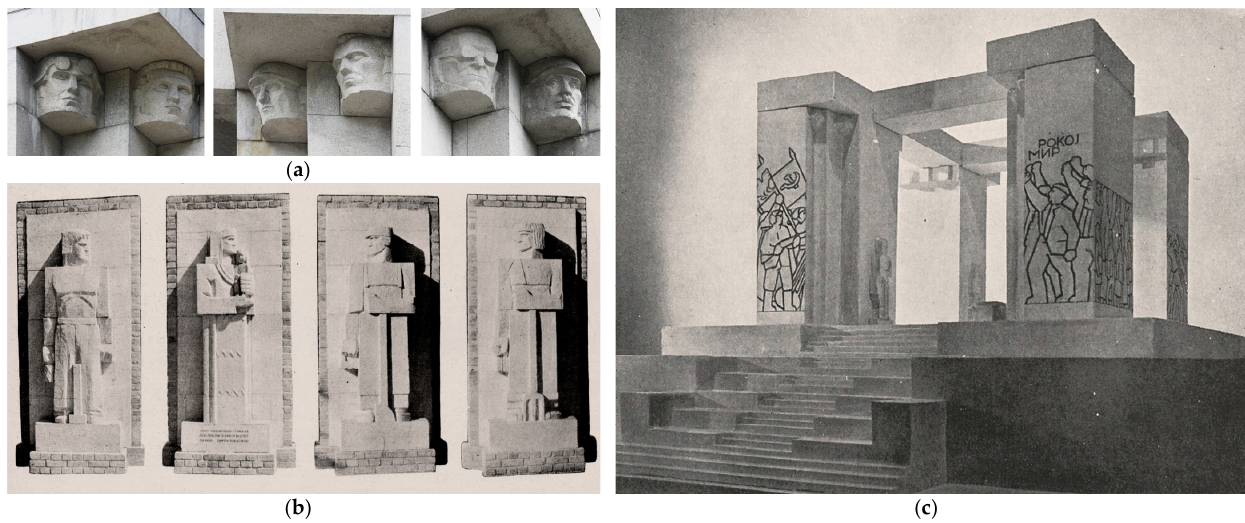
Figure 6. Saint Anne Mountain, the Monument of the Insurgents’ Deed, Xawery Dunikowski’s: ( a ) sculptures of the heads placed under architrave (photo 2019, created by authors), ( b ) models of the “convex sculptures” (Jassem and Minorski 1948, p. 6), ( c ) model of the dolmen (Xawery Dunikowski i jego uczniowie 1956, p. 18).